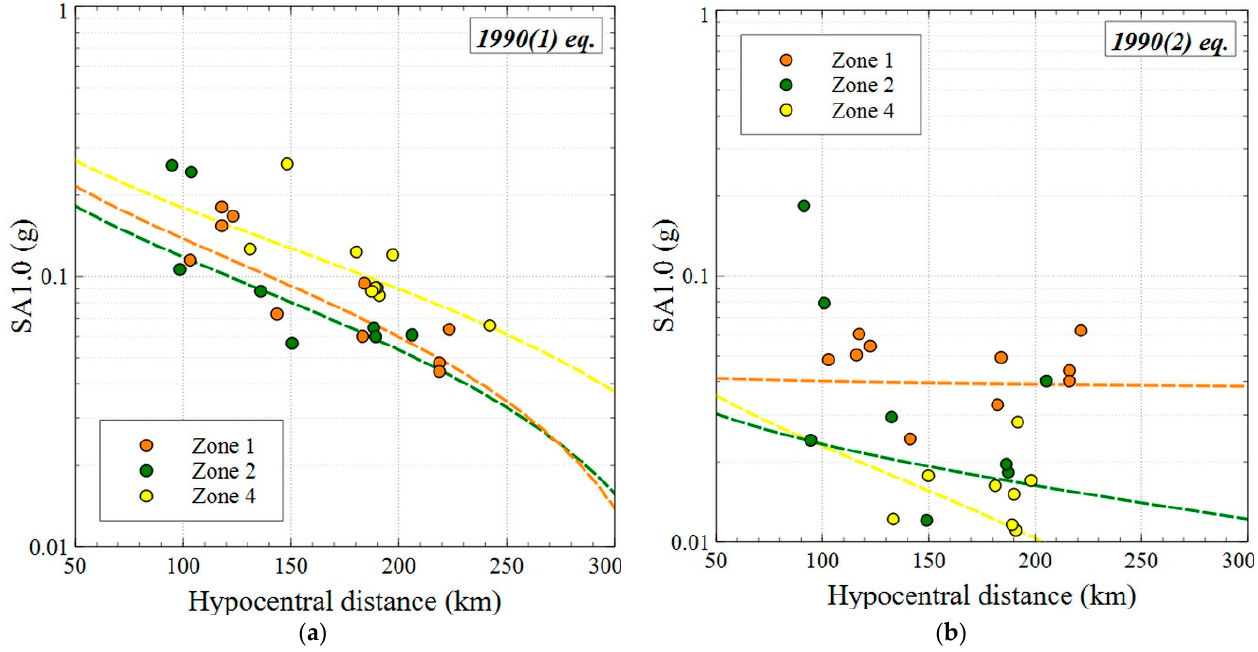
Figure 11. Comparison between the hypocentral distance attenuation curves for the spectral acceleration at 1.0 s for: ( a ) the 1990(1) Vrancea earthquake; ( b ) the 1990(2) Vrancea earthquake. With dashed lines are shown the corresponding logarithmic fit curves.